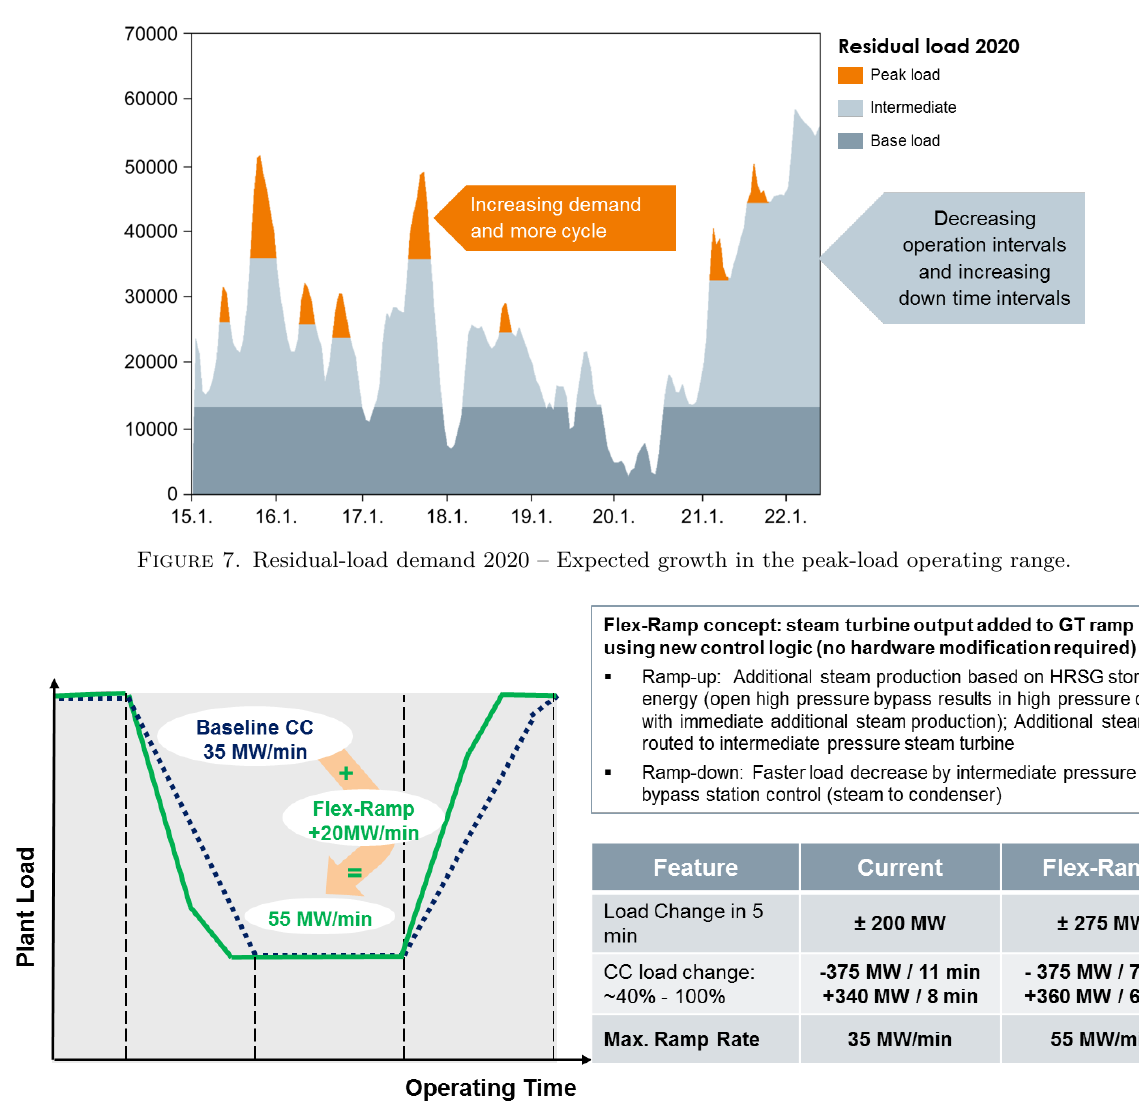
Figure 8. Load Ramp Test at Lausward CHP